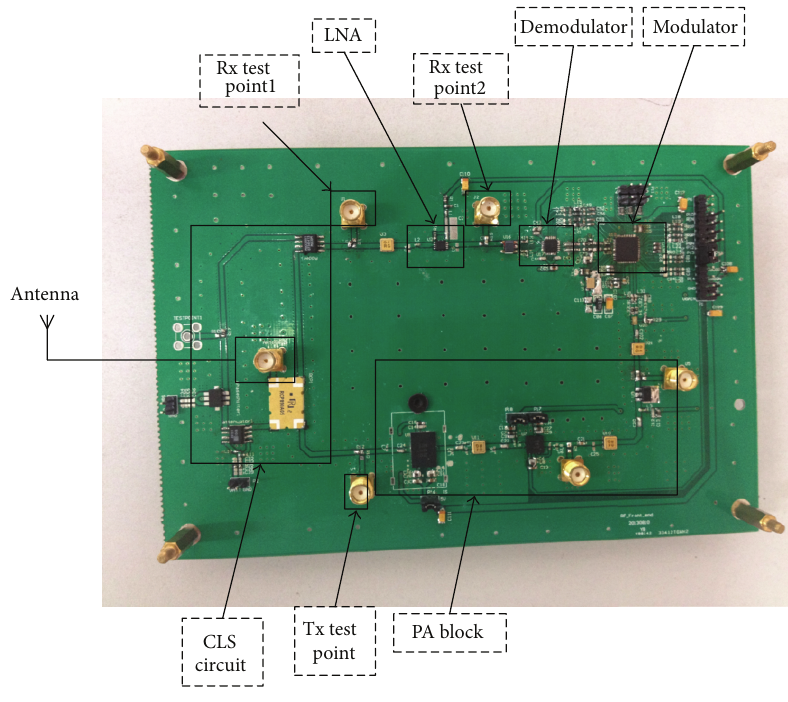
Figure 9: Photograph of the fabricated board.